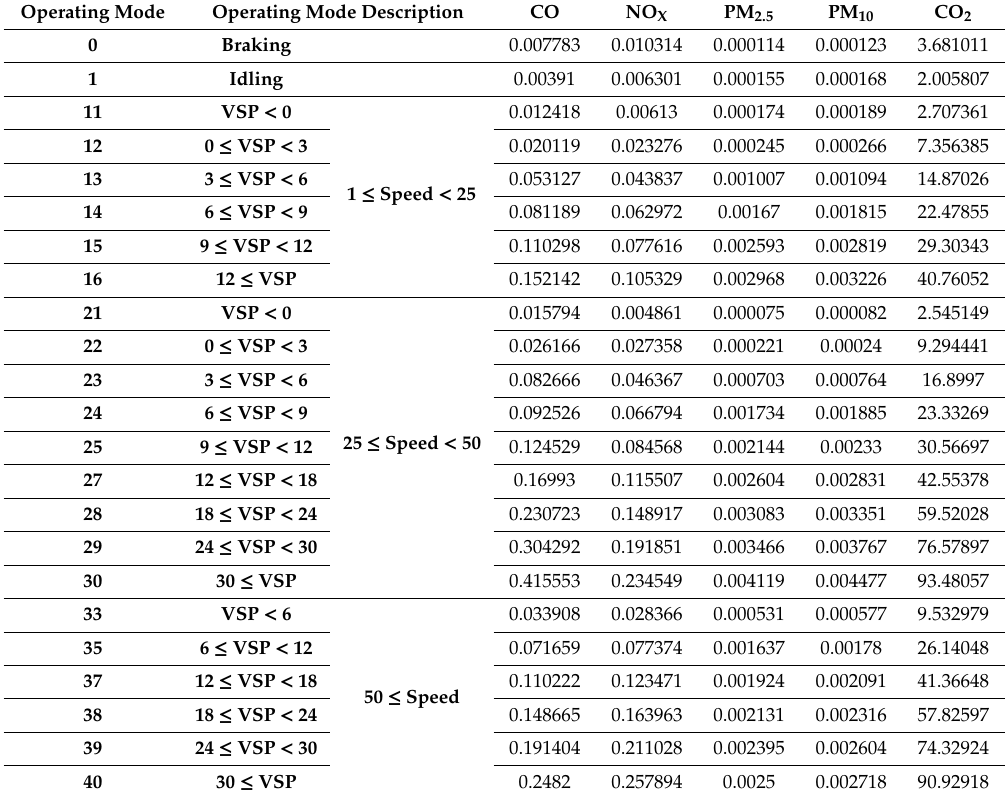
Table A3. Calculated Emission Rates (g / s) by OpMode for a Bus in Gyeonggi-Do,